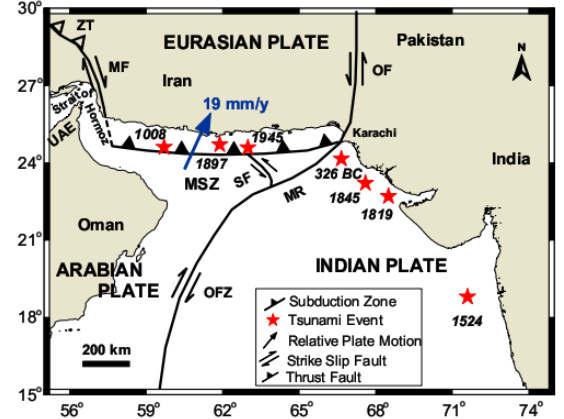
Figure 1. The tectonic map of the Makran subduction zone and historical tsunamis. Abbreviation are: Makran Subduction Zone (MSZ), Zagros thrust (ZT), Minab Fault (MF), Senne Fault (SF), Murray Ridge (MR), Owen Fracture Zone (OFZ),